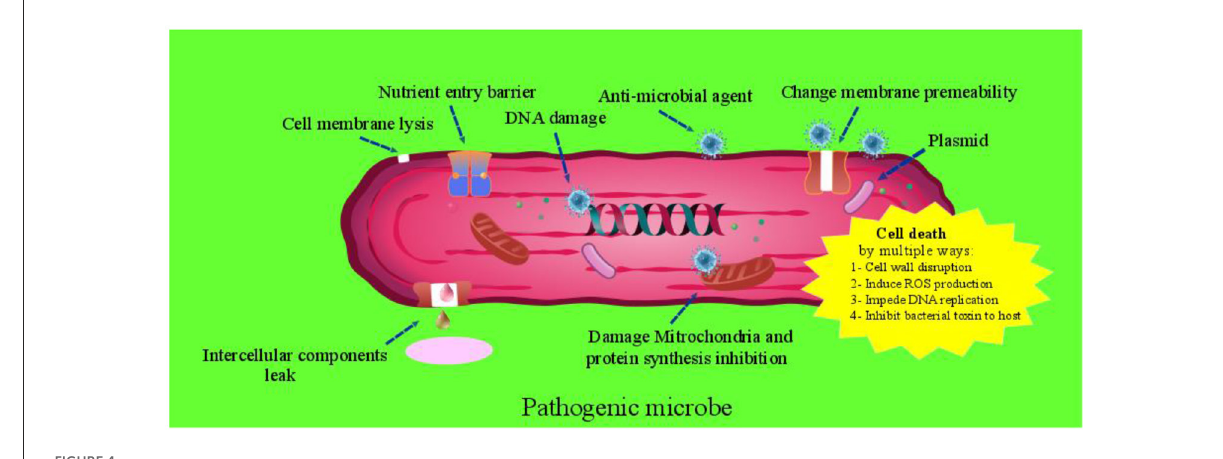
FIGURE4 Antimicrobial mechanism of bioactive compounds.